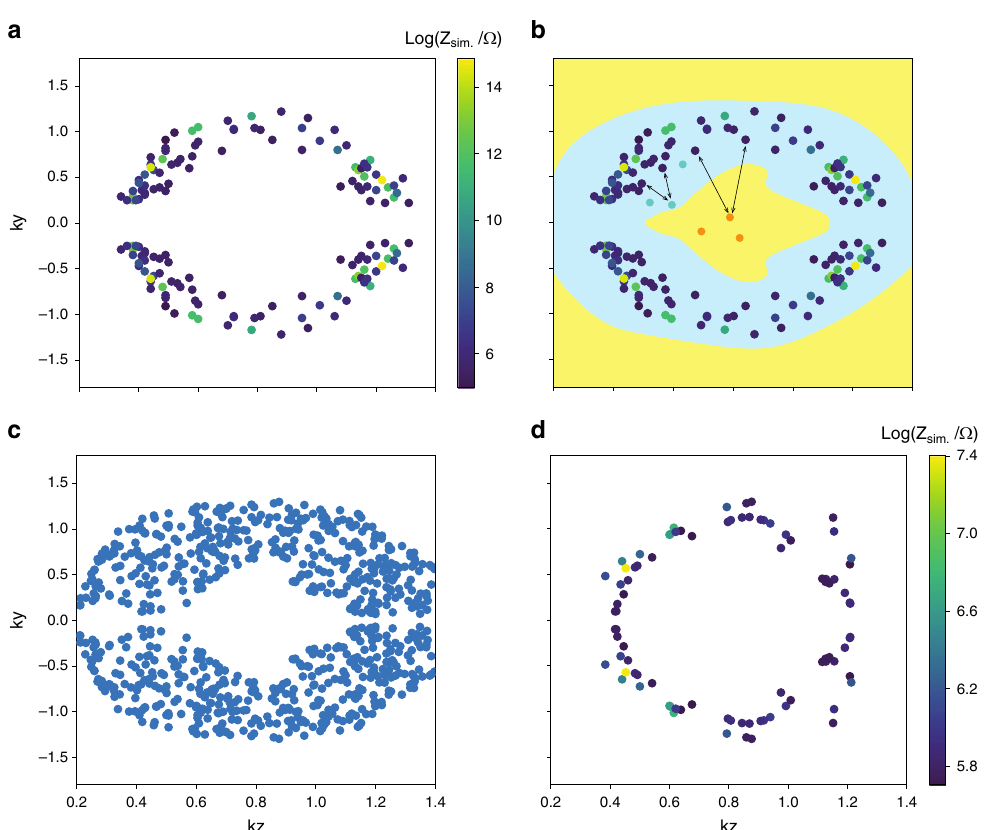
Fig. 8 Machine learning optimization of ( k y , k z ) measurement points. a Initial suboptimal set of ( k y , k z ) sampling points for the drumhead region, subject to a relatively relaxed criterion of log j Z avg (cid:1) Z SD j > 5 : 2, where Z SD is the standard deviation of the impedance subject to 1% tolerance in the capacitances and inductances with parasitic resistance R p L = 0.11 Ω , R p C = 0.03 Ω . While possessing higher impedance than points outside the drumhead region with ∣